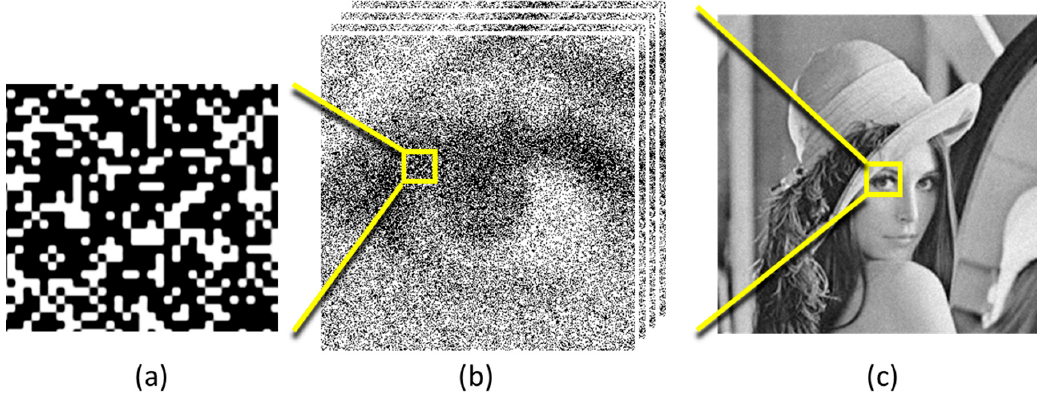
Figure 2. Simulation of ( a ) raw jot data; ( b ) same at lower magnification; ( c ) after processing cubicles to form grey scale image. From [16].